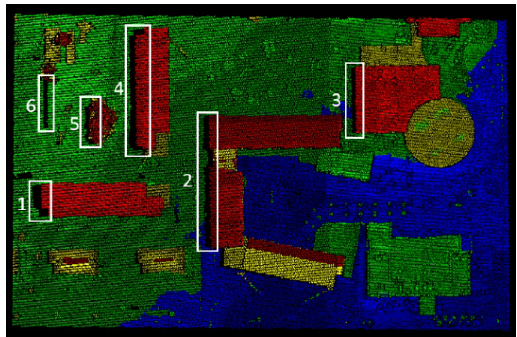
Figure 8. Artificial hole